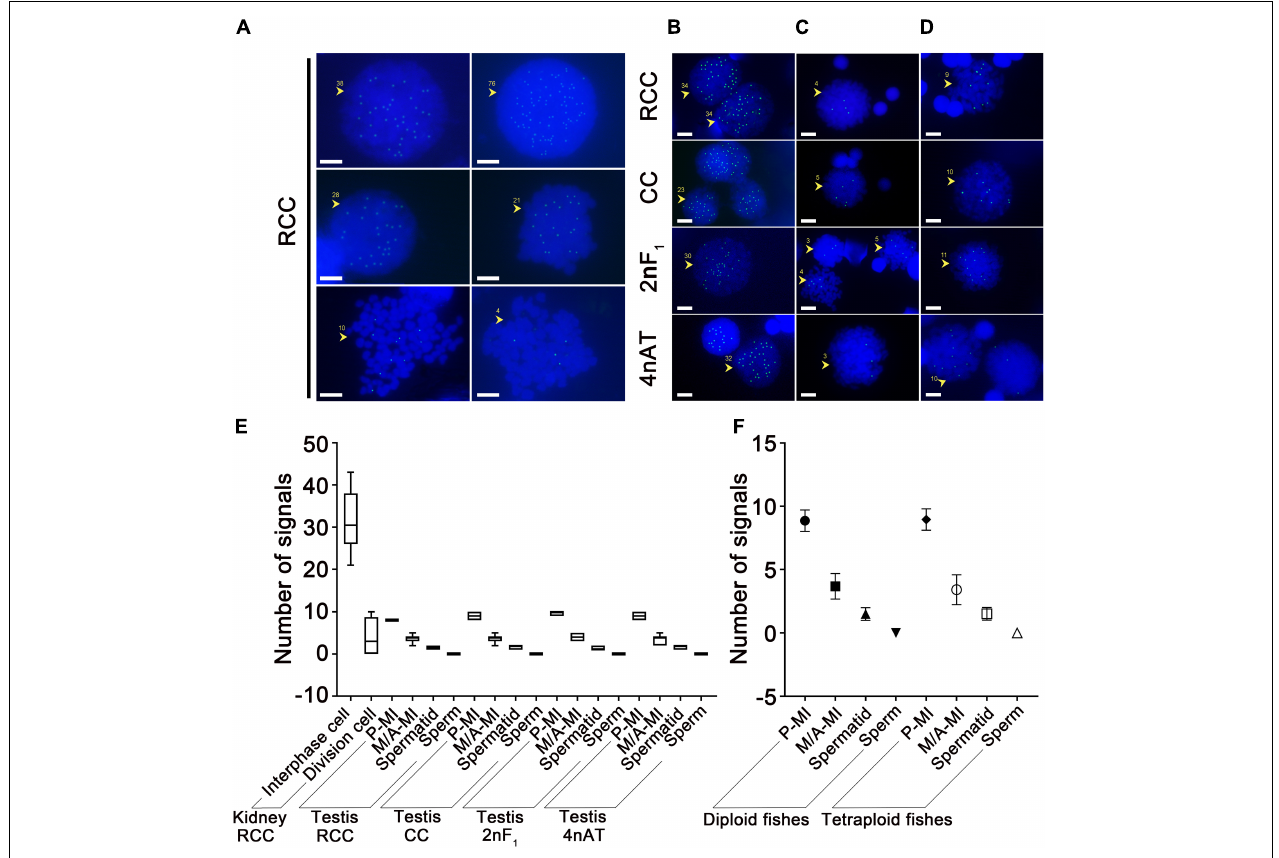
FIGURE 1 | Localization of RNA Pol II CTD (S5) in the nucleus of diploid and tetraploid fishes. (A) The somatic cells of RCC presented 38–76 signals in interphase cells, 21–28 signals at the prophase stage of mitotic cells, and 1–10 signals in metaphase-stage cells, panels (B–D) , respectively. The germ cells of RCC, CC, 2nF 1 , and 4nAT presented signal distribution in the nuclei of panel (B) prophase of meiosis I cells (20–40 signals), (C) metaphase of meiosis I cells (2–5 signals), and (D) anaphase of meiosis I cells (8–10 signals). (E) Statistics of signal numbers in somatic and germ cells of all species are shown, (F) and these were classified as a comparison of diploid and tetraploid. The original data of the signal numbers are shown in Supplementary Tables 1 , 2 . P-MI, prophase of meiosis I; M-MI, metaphase of meiosis I; A-MI, antaphase of meiosis I; Spd, spermatid. The yellow arrows and numbers indicate the number of signals on the cell; bar = 5 µ